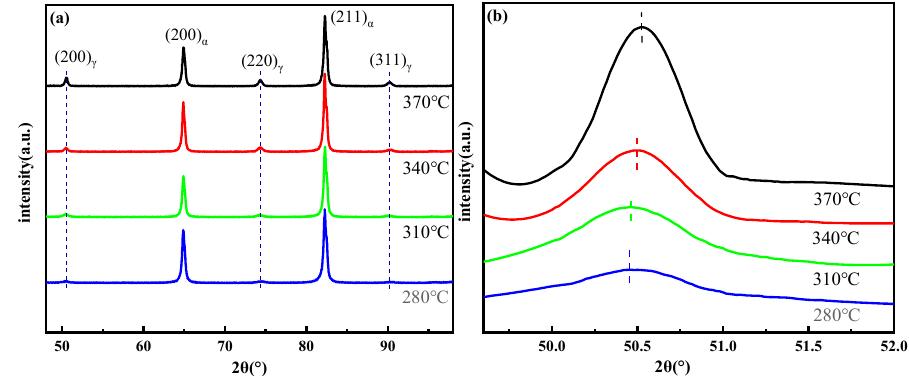
Figure 6. ( a ) XRD spectra and ( b ) enlarged view of (200) γ . where (200) γ , (220) γ , and (311) γ are the austenite peaks and (200) α and (211) α are the ferrite peaks.